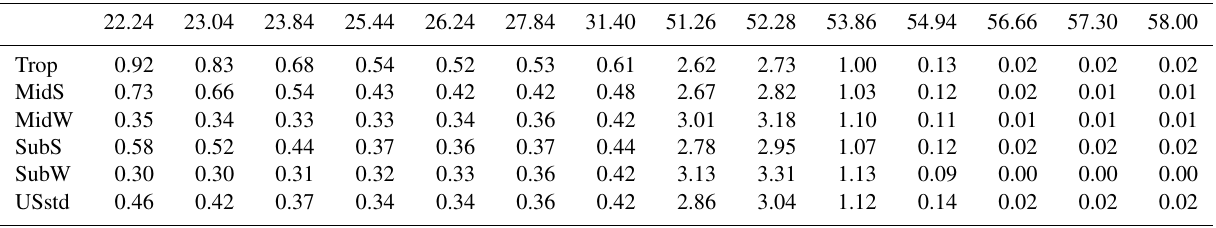
Table 4. Uncertainty on simulated T B ( σ ( T B )) at 14 HATPRO channel central frequencies due to the uncertainty in O 2 and H 2 O absorption model parameters. σ ( T B ) is computed as the square root of the diagonal terms of Cov ( T B ) , which was estimated considering the six climatological atmospheric conditions introduced in Fig.